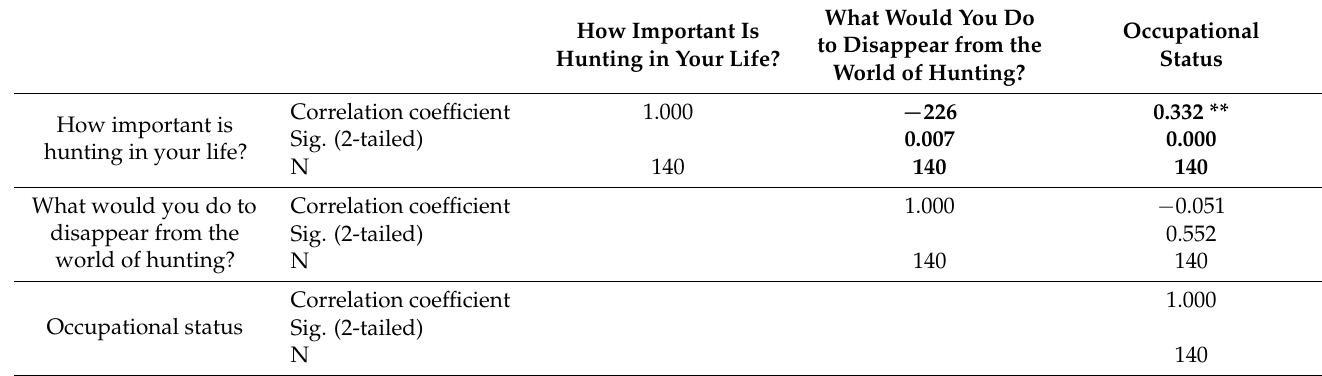
Table 5. Correlation coefficients for Spain.